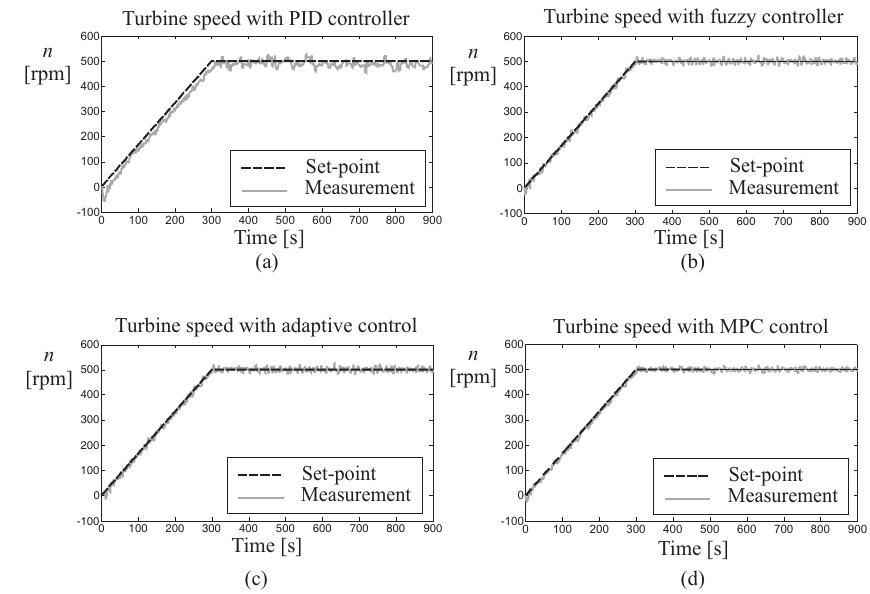
Figure 10. Hydroelectric system with ( a ) the self-tuning PID regulator, ( b ) the fuzzy controller, ( c ) the adaptive regulator, and ( d ) the MPC approach with disturbance